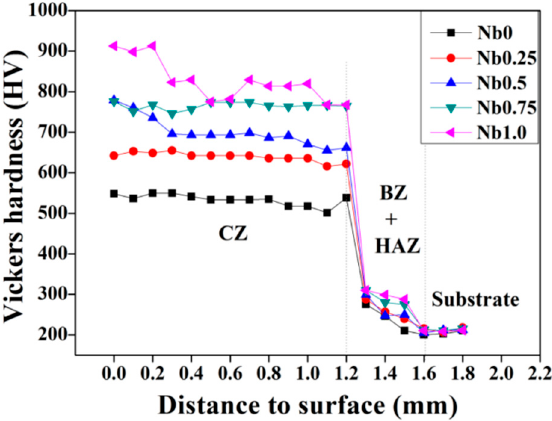
Figure 5. Vickers hardness of the substrate and AlCoCrFeNiNb x (x = 0, 0.25, 0.5, 0.75, and 1.0) alloy coatings.